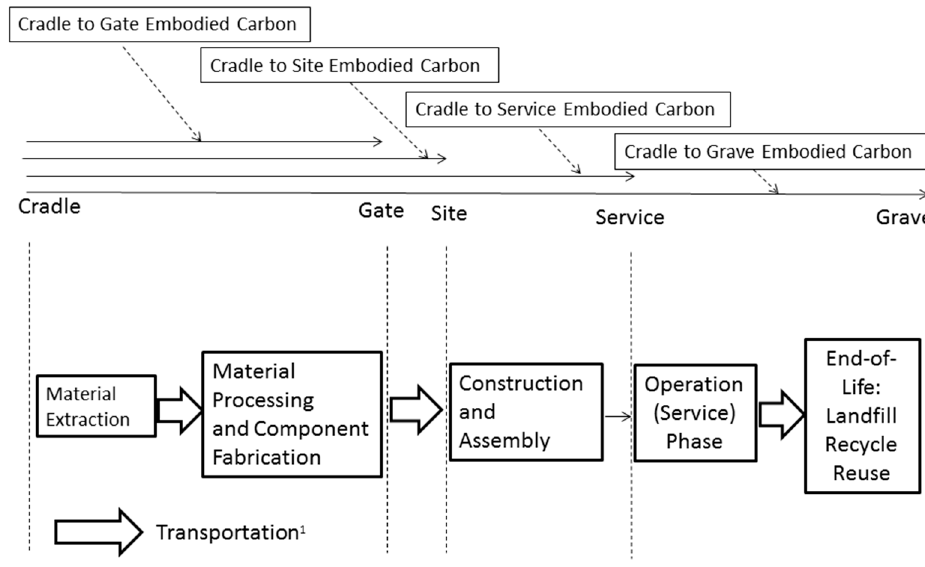
Figure 1. Different phases of a building’s life cycle .